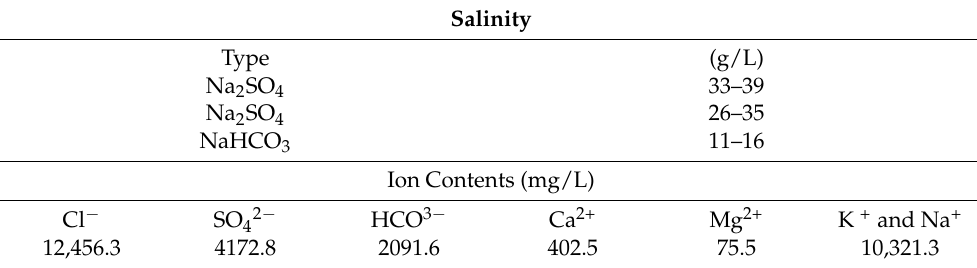
Table 1. Kashkari oil field FW salinity.